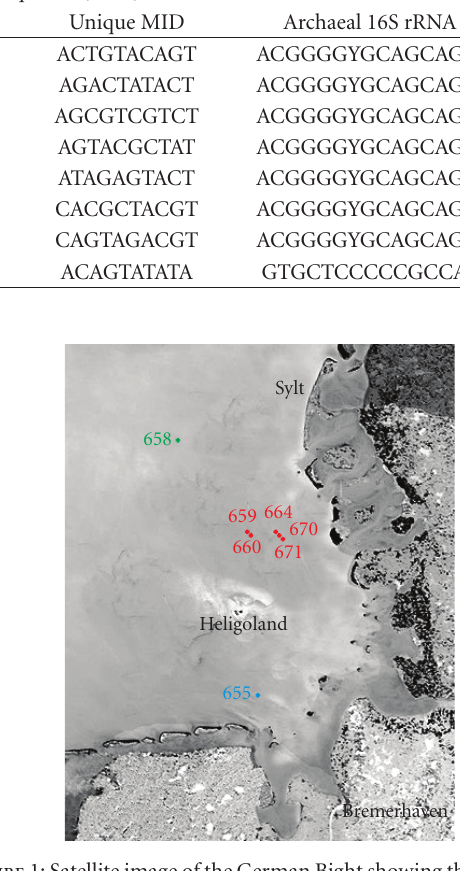
Table 1: Primers used for amplification of the V3–V5 region of the archaeal 16S rRNA [20]. Sample